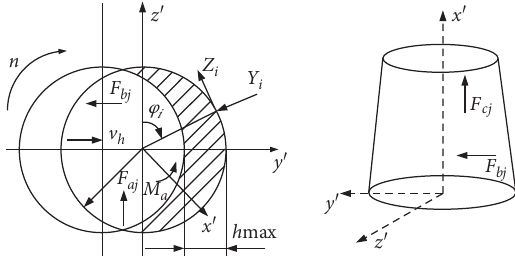
Figure 2: Transverse swing of cutting head.